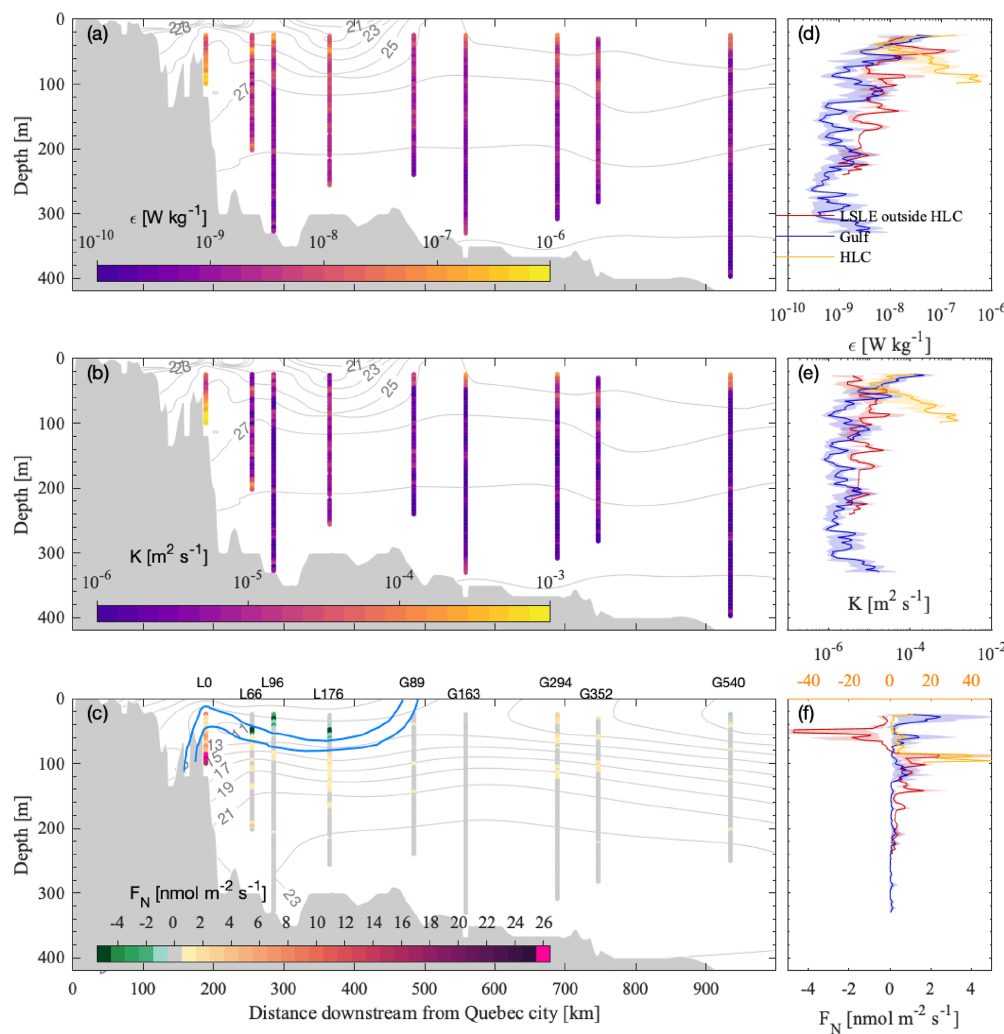
Figure 7. (a) (cid:15) , (b) K , and (c) F N after time-averaging the repeated VMP profiles at each station. We present the average profiles for the lower estuary (outside the HLC) and in the gulf for (d) (cid:15) , (e) K , and (f) F N . The error bands represent 95% confidence intervals obtained through bootstrap analysis on the averages within each region. The HLC’s vertical fluxes in (f) are shown on a separate axis. The gray contour lines in (a) and (b) represent isopycnals (in σ T , kgm − 3 ), whereas those in (c) are the nutrient contours (in mmolm − 3 ) shown in Fig. 5b. Positive values in (c) indicate an upward flux of nutrients. The thick cyan lines in (c) are the same as in Fig. 3 – the 31.2 and 31.9 isohalines that delineate water originating from the upper estuary ( S < 31 . 2) and from the gulf ( S > 31 . 9). The contour lines were obtained using a data-interpolating variational analysis (DIVA) technique (Troupin et al.,